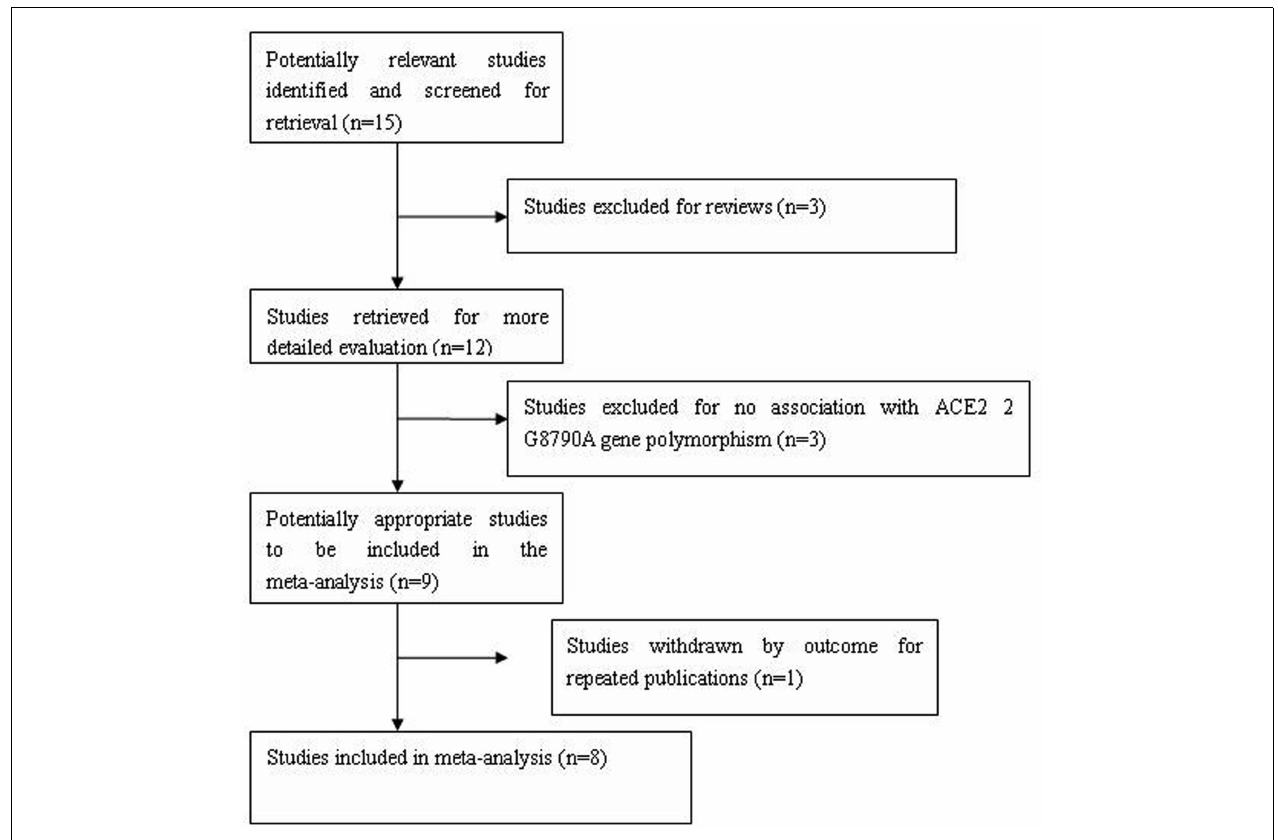
FIGURE 1 | Flow diagram of articles selection process for ACE2 G8790A gene polymorphism and EH risk